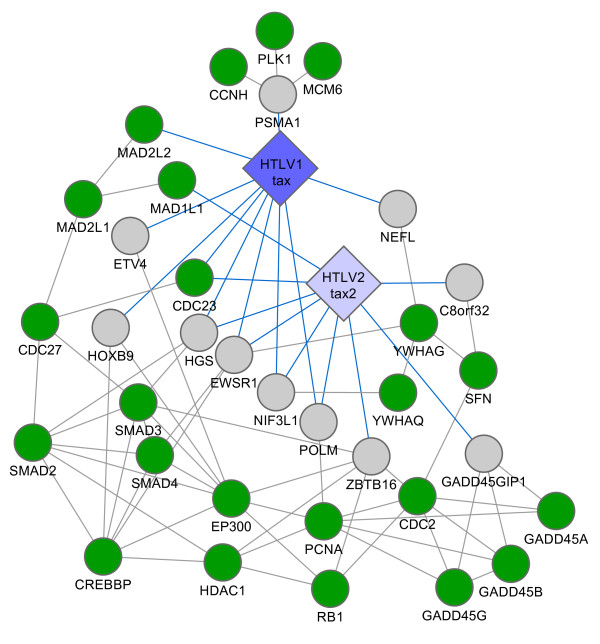
Targeting of the cell cycle by viral proteins. Schematic representation of PPIs. Big diamonds: viral ORFs, with HTLV-1 and HTLV-2 in blue and light blue, respectively. Small circles: human ORFs with green representing membership of the cell cycle. Grey links: human-human PPIs; blue links: virus-human PPIs.